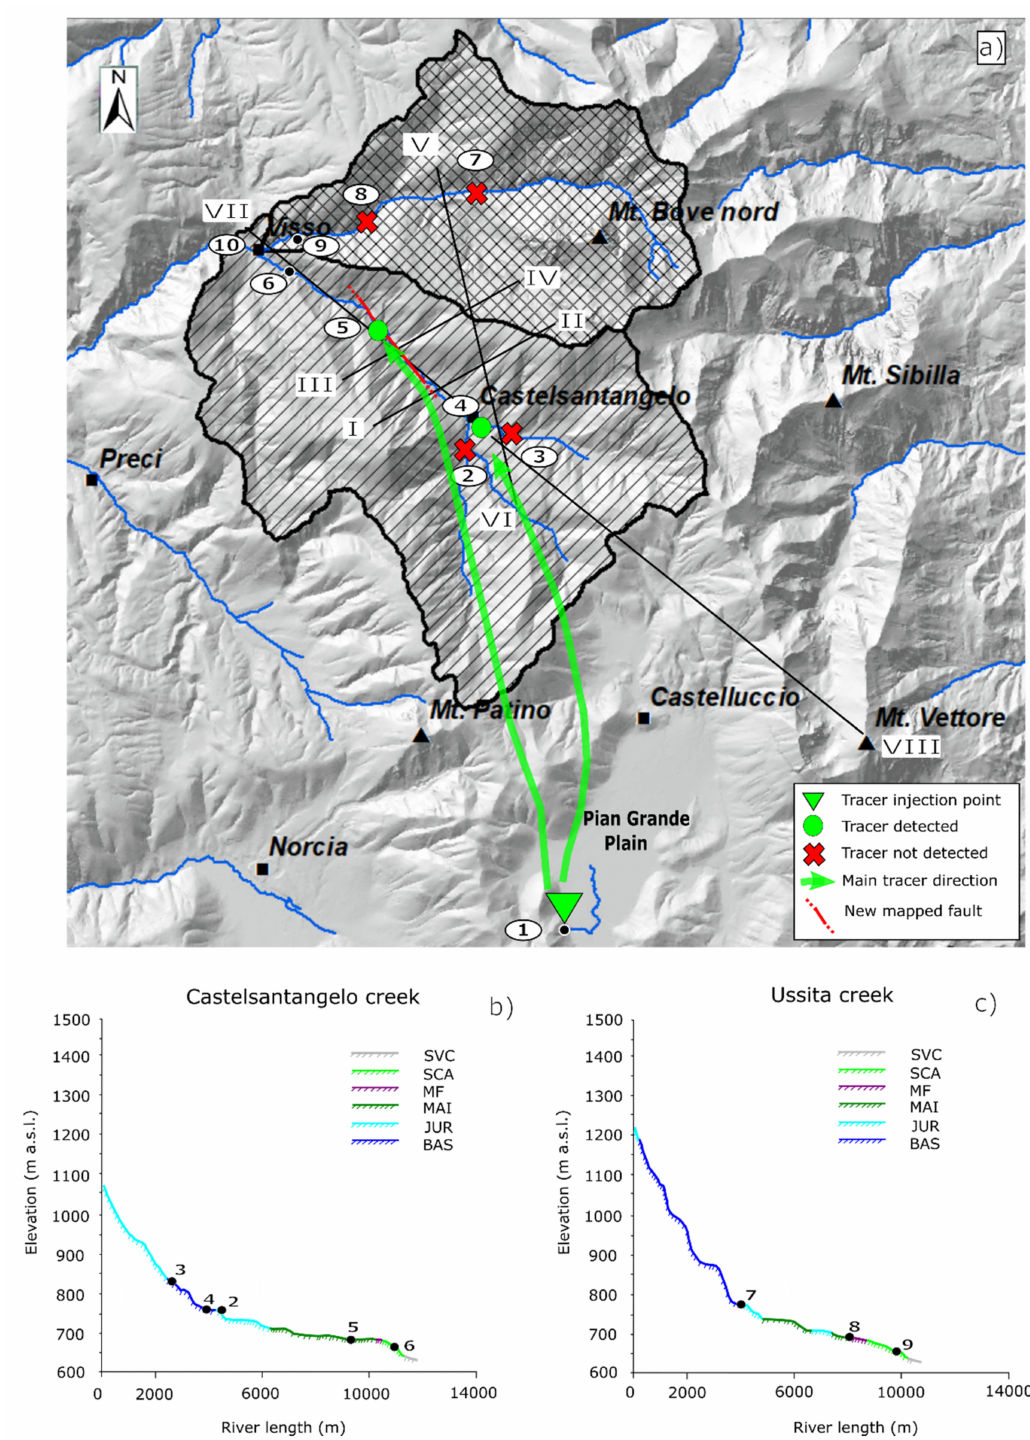
Figure 8. ( a ) Location of the new mapped fault and main tracer direction from injection point (point 1 in the map in Figure 2) to the analysed basins. The green dots refer to the point where the tracer has been recovered (point 4 and 5) while the red crosses refer to the monitoring point where the tracer has not been detected in this study (point 2, 3, 7 and 8). The monitoring point 6, 9 and 10 are not instrumented for tracer detection. ( b , c ) Streams topographic intersection with the hydrogeological complexes and localization of the monitoring points for the analyzed basins: ( b ) Castelsantangelo creek ( c ) Ussita